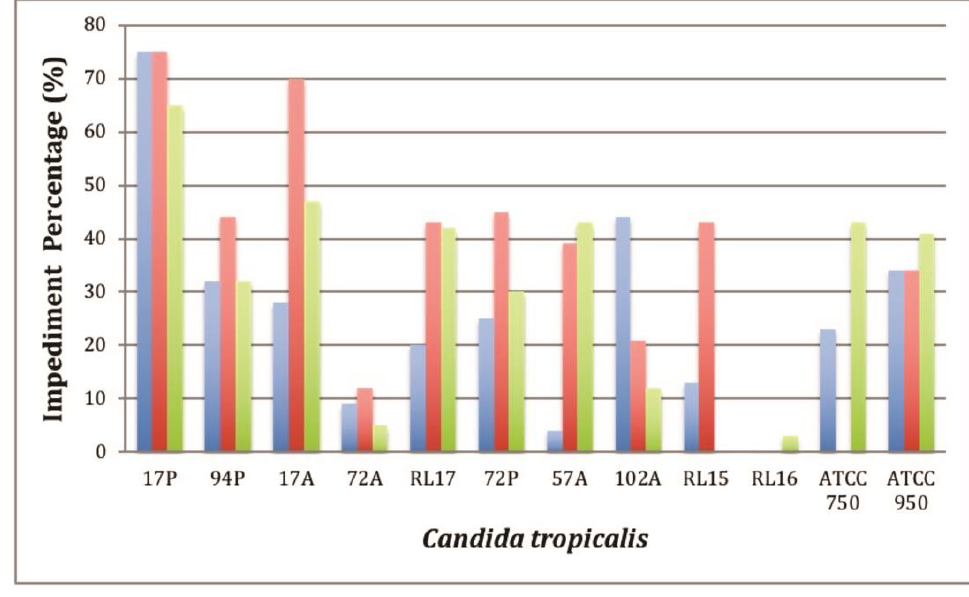
Figure 6. In vitro minor antibiofilm concentration assay: impediment percentage for HDPE.Cl.0125 (blue bars), HDPE.Cl.0250 (red bars), and HDPE.Cl.0500 (green bars).